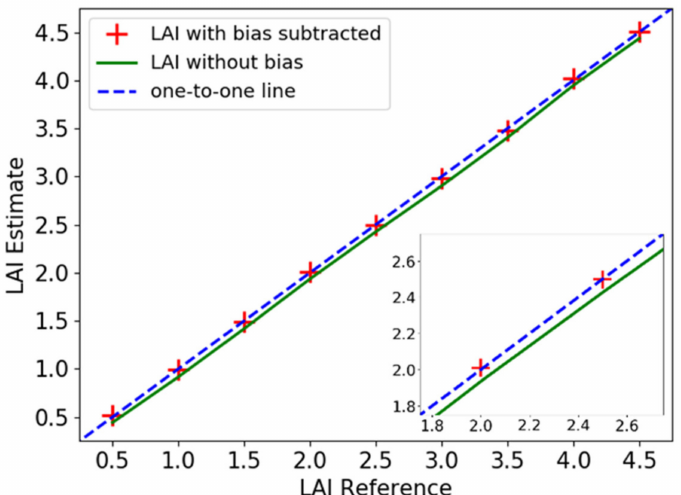
Figure 10. Accuracy of the slope method for finding the extinction coe ffi cient, k . The plot compares the estimated LAI to the “truth” or reference LAI. Red crosses are the LAI estimates with the bias accounted for, while the solid green line shows where the estimates would lie without accounting for the bias (small zoomed insert shown, bottom-right). The blue dashed line is the one-to-one